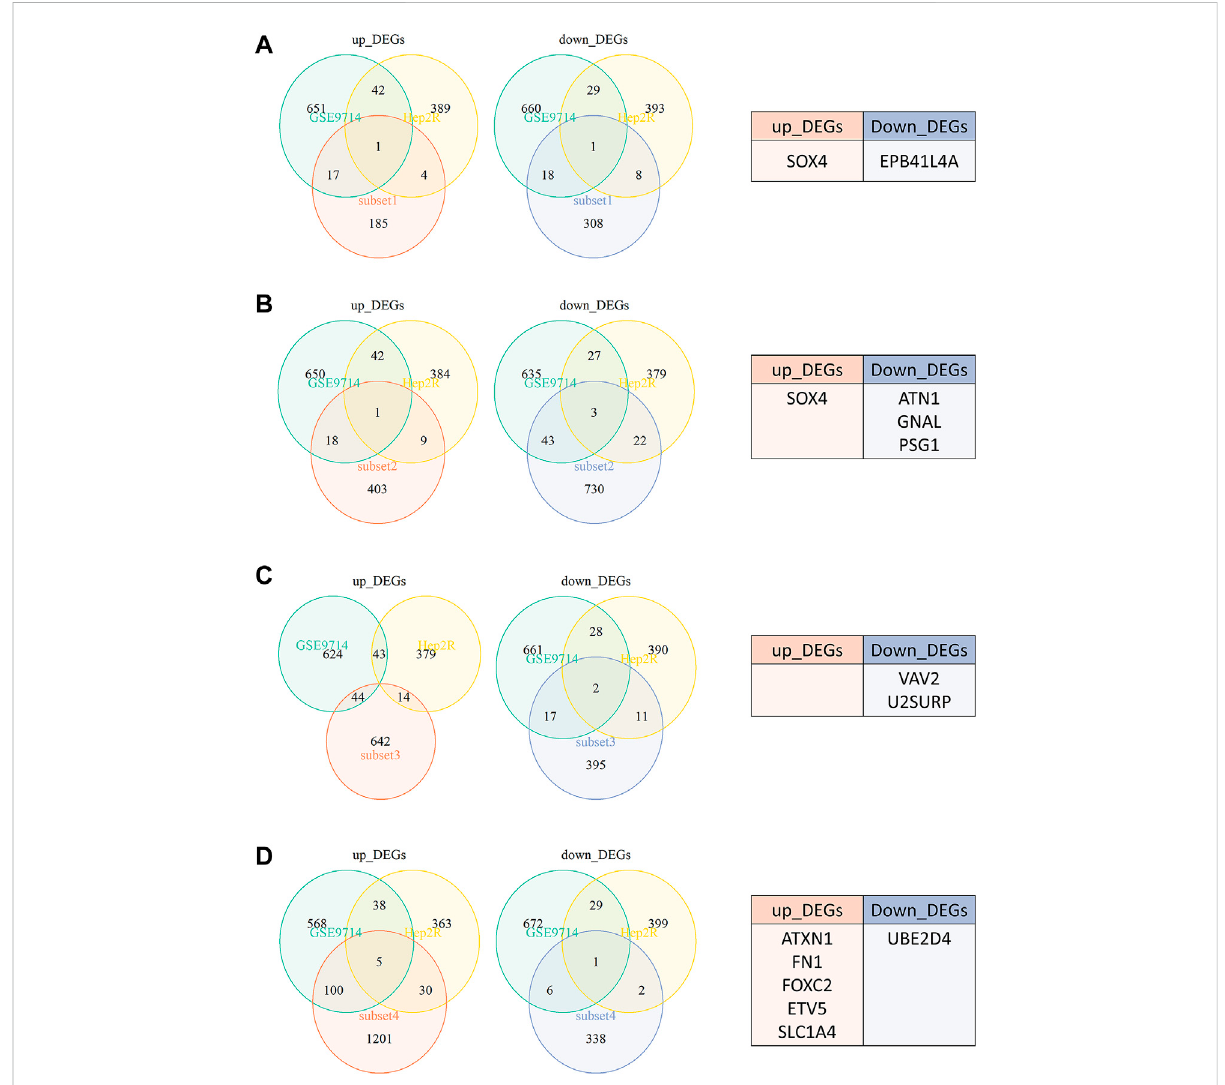
FIGURE 3 The Venn diagram revealed that a totalof 13 DEGs were found when our data (Hep2versusHep2-R)and GSE9714 compared with four subsets. (A) Subset 1-six radiosensitive tumors versus six radioresistant tumors without irradiation. (B) Subset 2-three radiosensitive tumors versus three radioresistant tumosr with irradiation. (C) Subset 3-three radiosensitive tumors versus three radioresistant tumors 5 h after irradiation. (D) Subset 4- three radiosensitive tumors versus three radioresistant tumors 24 h after